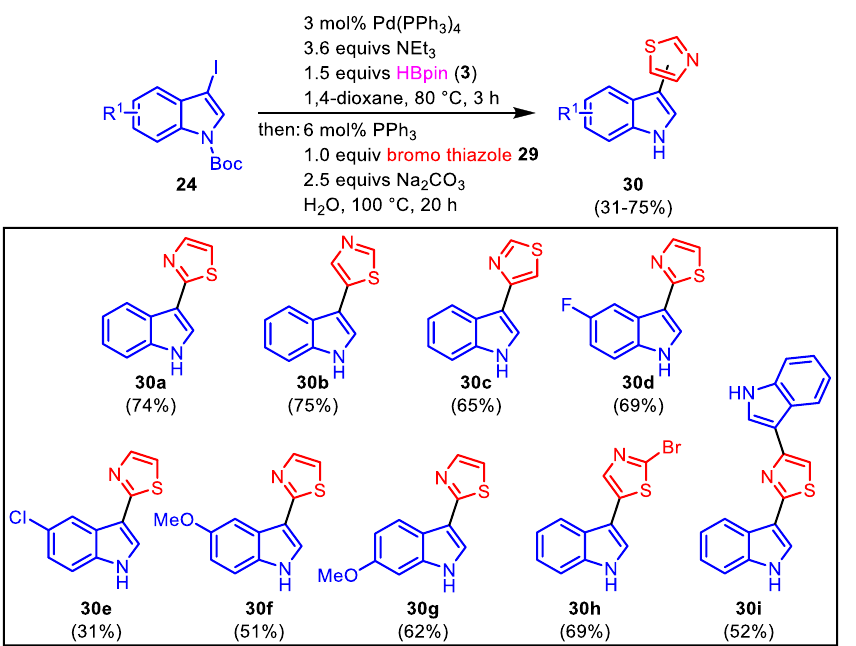
Figure 18. One-pot MBSC synthesis of camalexin derivatives 30 by Tasch et al. [50].